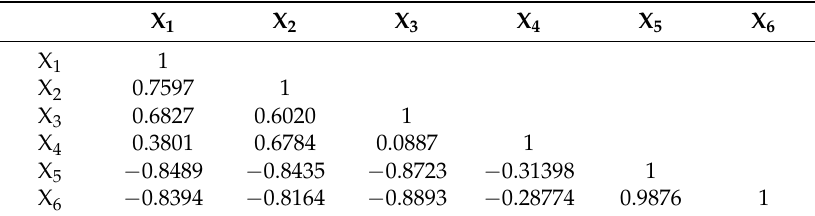
Table 4. Correlation matrix of input data for